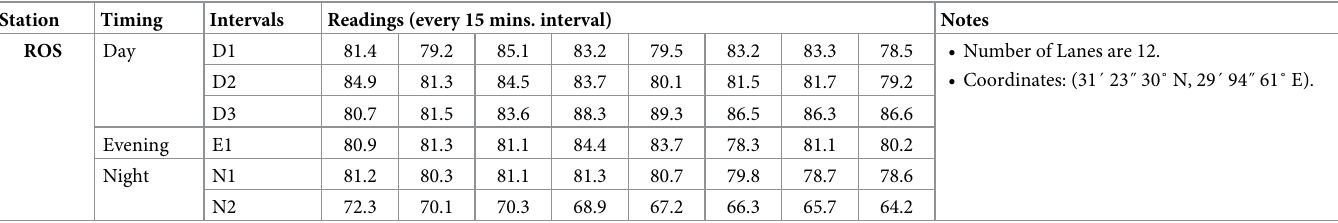
Table 7. The data sheet for Roushdy Station (ROS) showing the noise level readings that were taken at the station on the selected intervals of the working day. Station Timing Intervals Readings (every 15 mins. interval) ROS